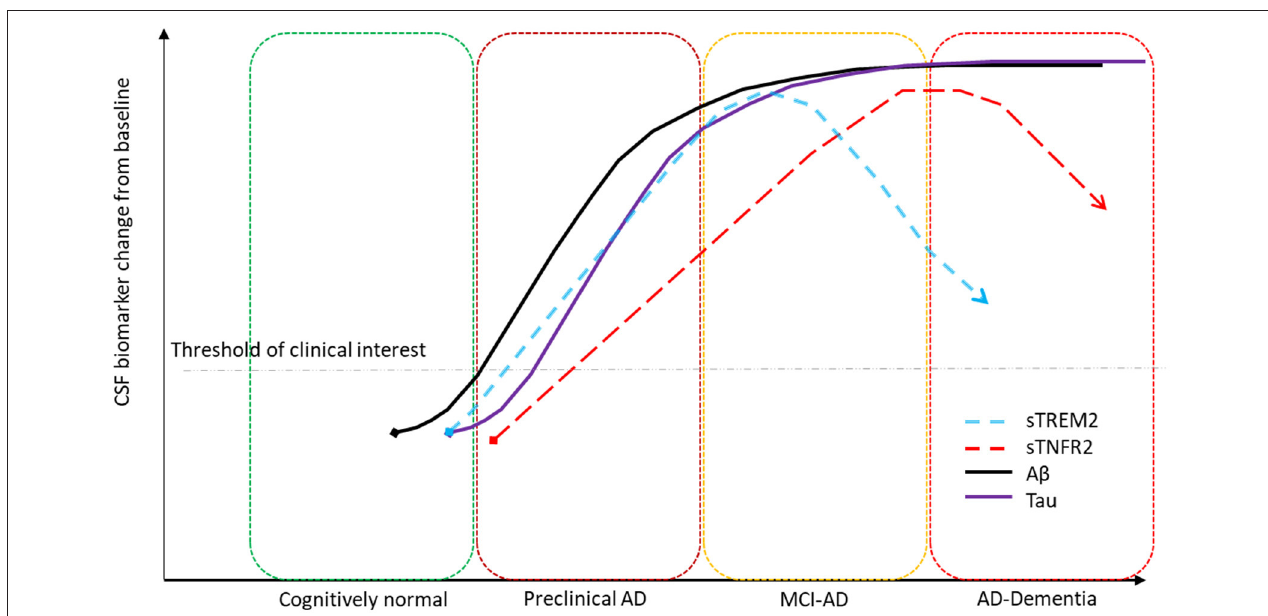
FIGURE 4 | Hypothetical model summarizing key biomarker findings. CSF sTREM2 significantly correlates to CSF p-tau levels in the A + T + preclinical and MCI stages of AD and CSF sTNFR2 significantly correlates to CSF p-tau levels in the A + T + MCI and dementia stages of AD.